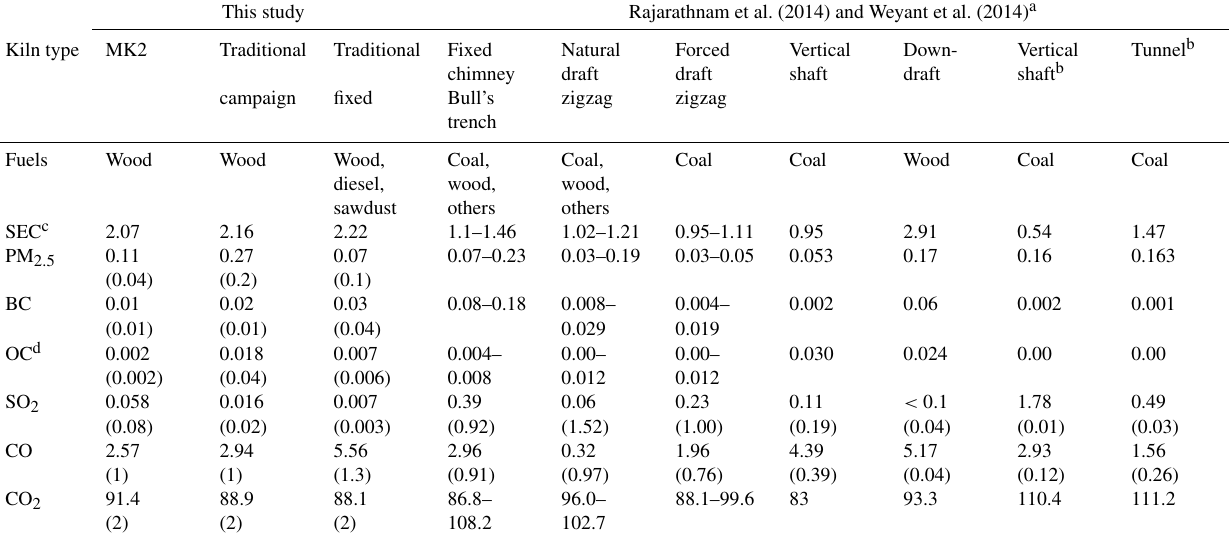
Table 3. Comparison of energy-based emission factors (gMJ − 1 ) measured in this study with other studies.